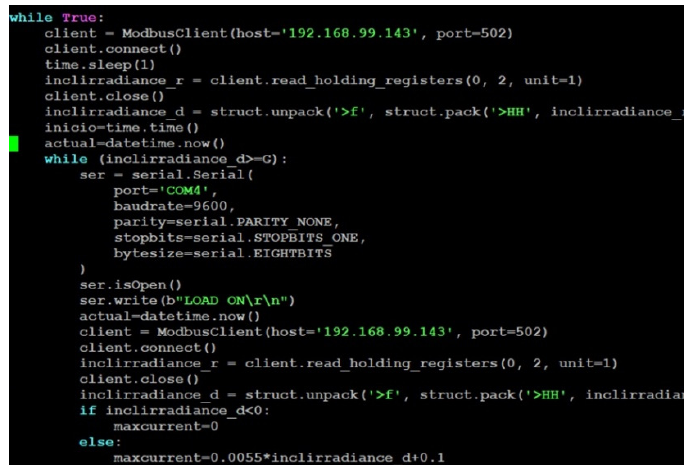
Figure 7. Python code for I ‐ V curve tracing.